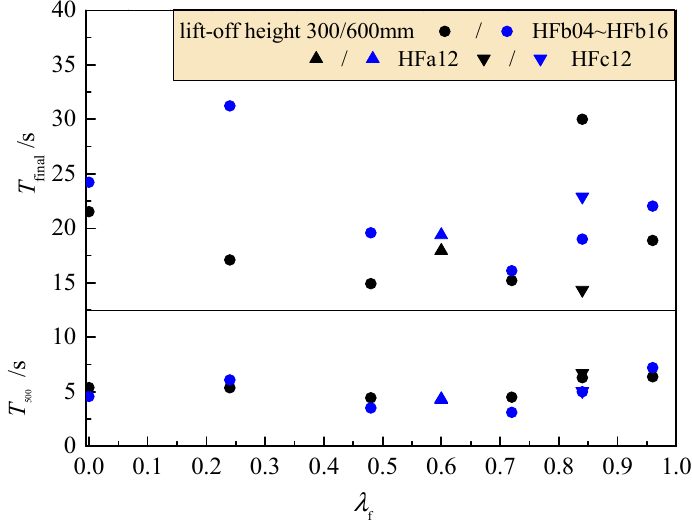
Figure 3. Flow time T 500 and T final with different lift-off heights changed with the fiber factor. Generally, a lift-off height of 300 mm in 3 s for the slump cone is adaptable to be used for the controlling parameter of the test operation. Since the standard height of the slump cone is 300 mm, the lifting height is equal to the height of the slump cone, which is convenient for intuitive comparison control. In this condition, as presented in Figure 4, the slump-flow of self-compacting SFRC is 560–685 mm with a flow time T 500 of 4.33–6.71 s. The degree of slump-flow met SF 1 or SF 2, and the level of flow time met VS 1. 550600 650700750800